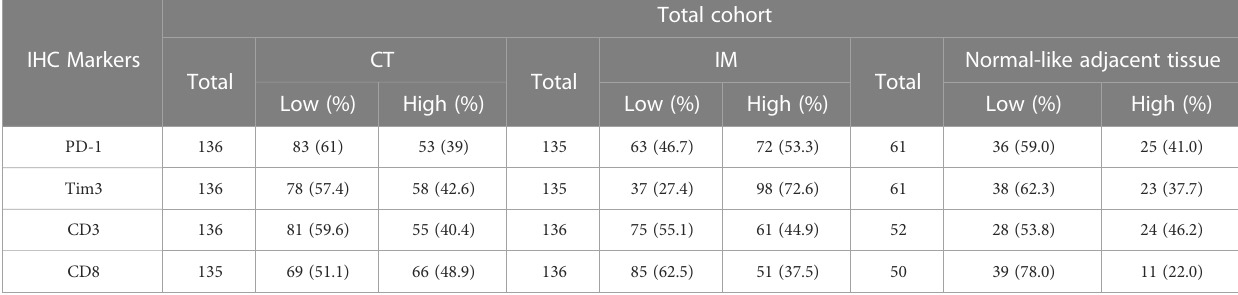
TABLE 2 Distribution of cases according to the expression of PD-1, Tim3, CD3, and CD8 markers.